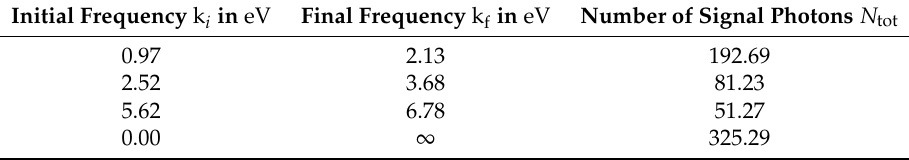
Table 1. Total number of signal photons per shot attainable with the suggested setup based on three pump laser beams of frequencies ω 0 = 1.55eV, 2 ω 0 = 3.1eV and 4 ω 0 = 6.2eV and one probe beam of frequency ω 0 = 1.55eV. All beams are pulsed and feature a pulse duration of τ = 25fs. Moreover, they are focused to a beam waist of w i = λ = 800nm. We assume a one petawatt and a two petawatt laser at our disposal: one generates the pump fields (two petawatt) and one the probe (one petawatt). This table provides the number of signal photons for different frequency ranges k i to k f . Initial Frequency k i in eV Final Frequency k f in eV Number of Signal Photons N tot